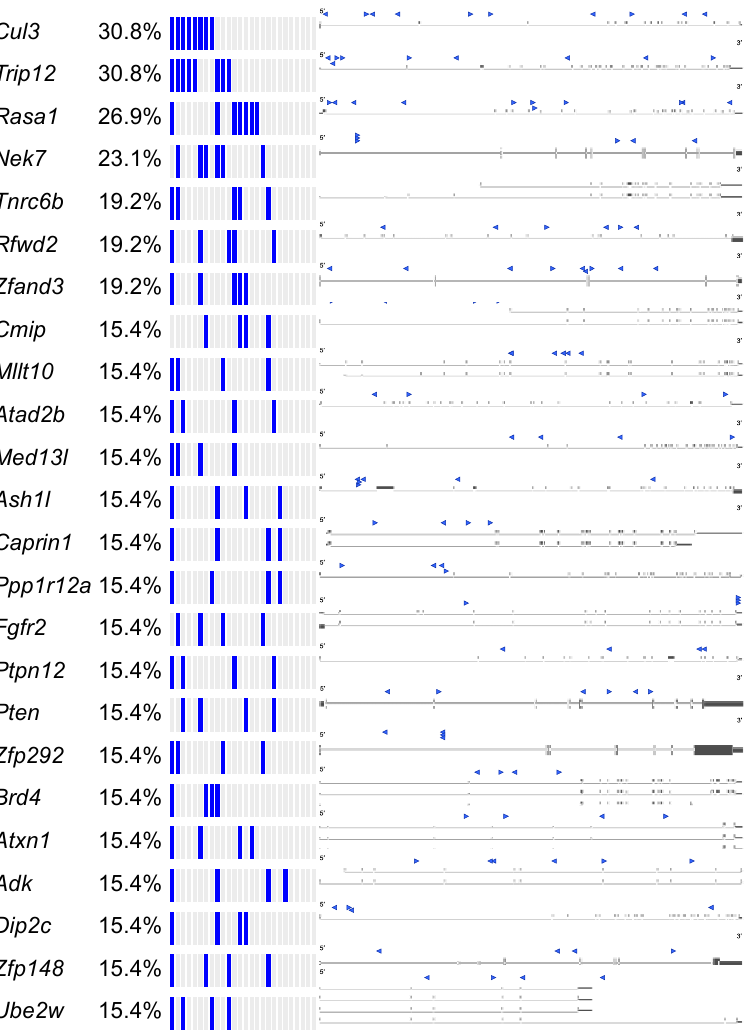
Figure 6. SB-Onc2.3-Pan-TSG driver discovery. Recurrent inactivating SB insertions into trunk drivers with >99 reads from 3 or more Onc2.3-induced cancer genomes (n = 27). SB-Onc2.3-Pan-TSG driver gene SB insertion profiles are shown on the right. Literature references summarizing studies that provide in vivo evidence for validation of the TSGs identified in this study (Table S23) [35]. The Cancer Gene Census (COSMIC v91 [36–38]) contains 313 genes with a designation of TSG and a unique mouse ortholog (Table S20). The Onc2.3-Pan-TSG dataset contains 1499 driver genes. We observed 78 genes in common between the CGC and the Onc2.3-Pan driver genes, which represent a statistically significant enrichment of shared genes than expected (Table S20; Chi-square with Yates’ correction, χ 2 = 104.742, two-tailed p < 0.0001). This suggests that the genes identified in our screen are enriched for known TSGs